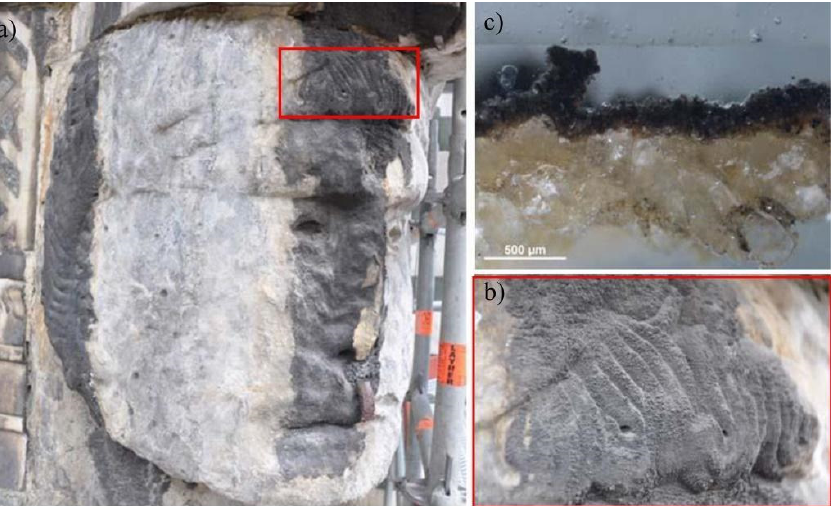
Figure 3. Scarsella, south corner. ( a ) Angular-shaped human head in marble: loss of molded and black crusts; ( b ) a detail of the black crust (red square); ( c ) a cross section of a micro fragment of a black crust.